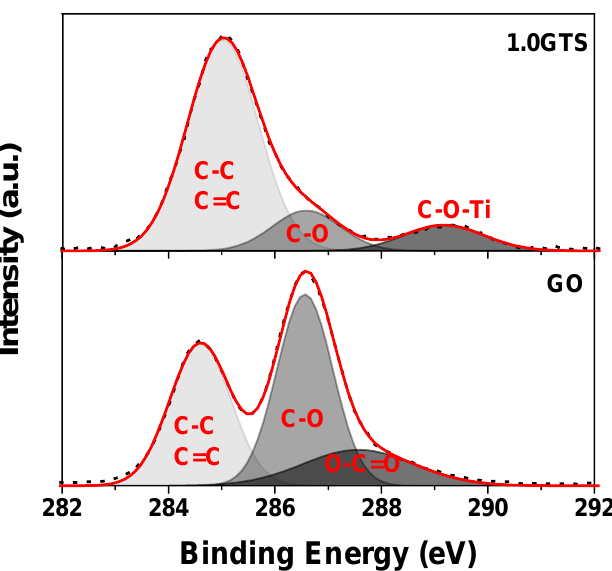
Figure 5. XPS of C 1 S of GO and 1.0GTS.